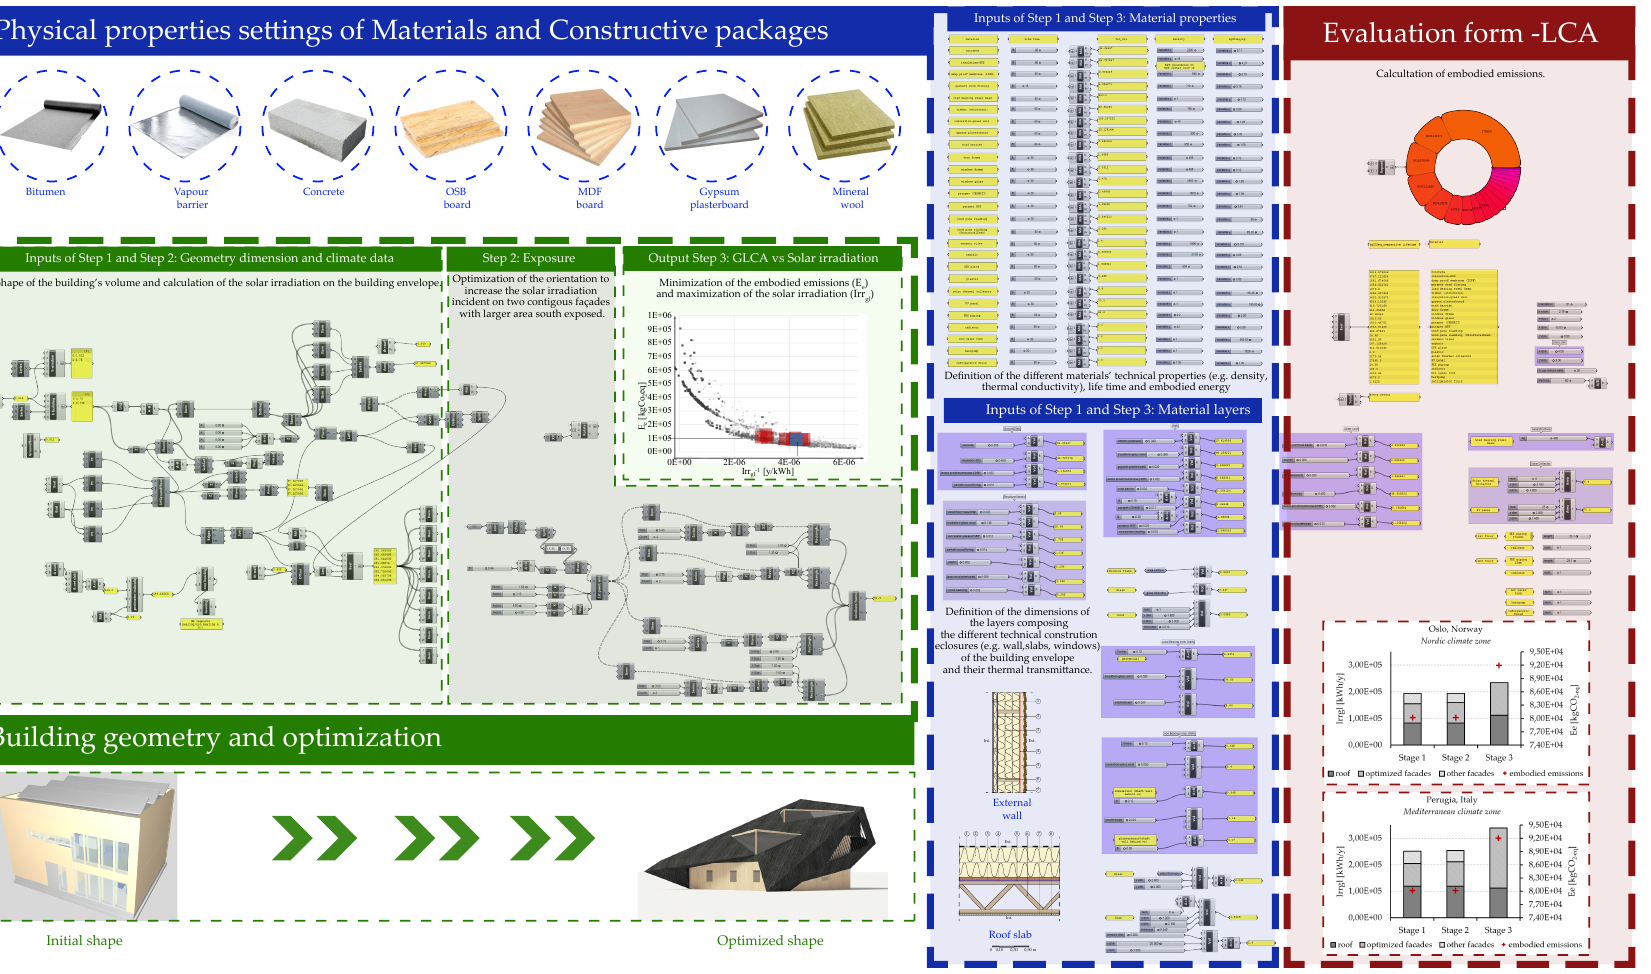
Figure 1. Overview of the algorithm developed in the Grasshopper environment with the di ff erent steps, inputs, and